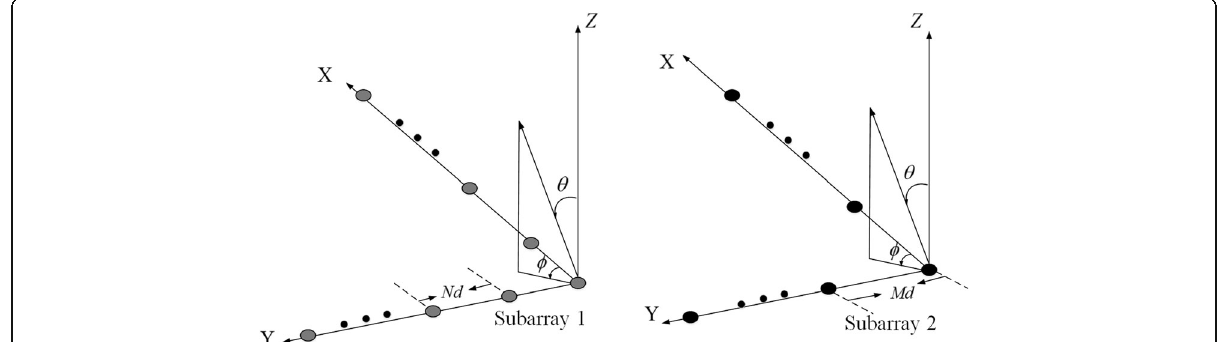
Fig. 6 The two L-shaped uniform arrays. It depicts two uniform arrays after splitting an L-shaped area